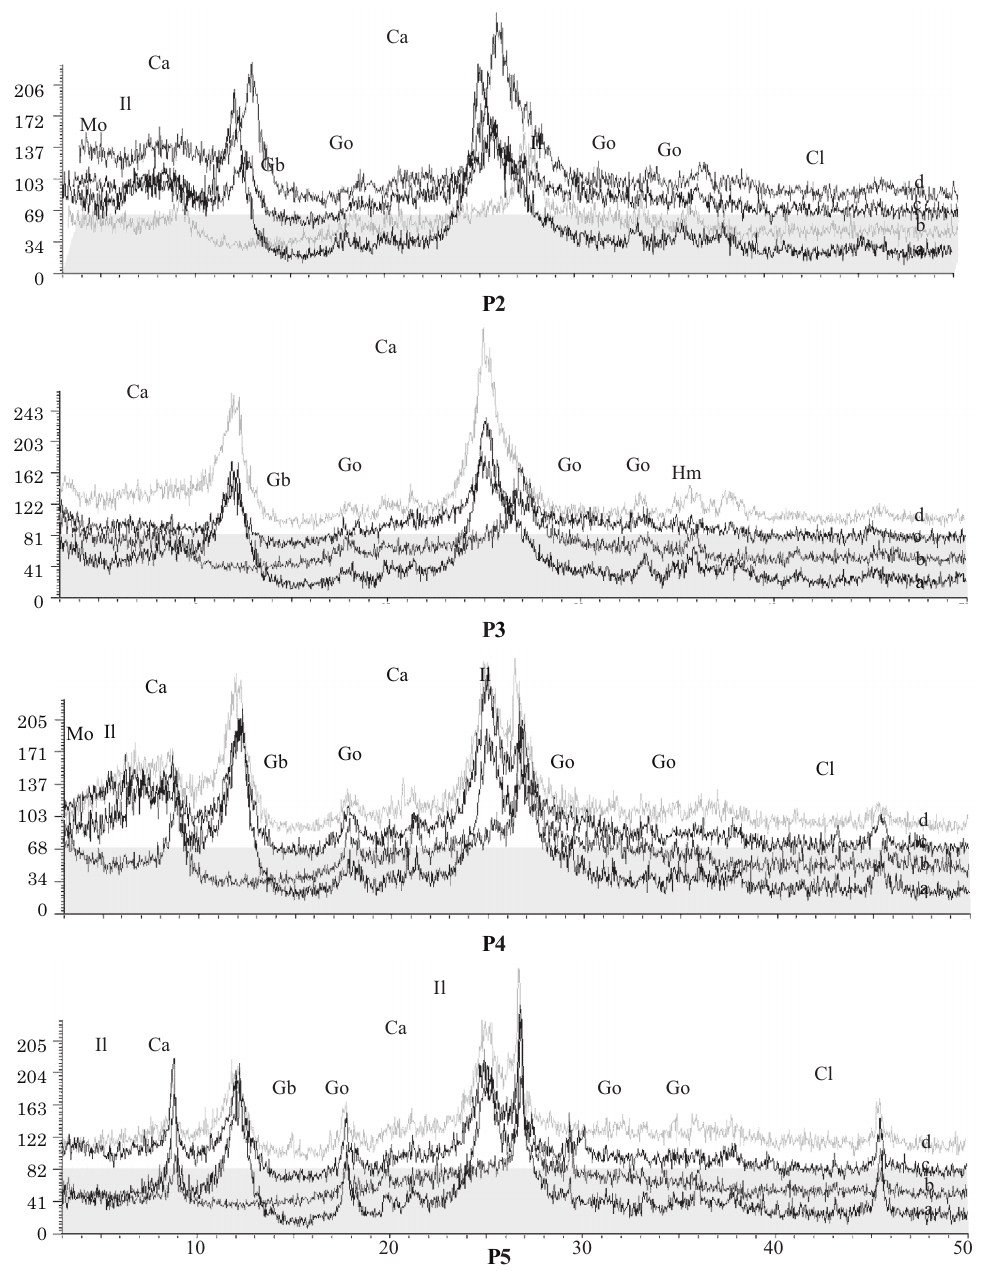
Figura 2. Difratograma de raios-X da fração argila dos perfis P2 (Bi2), P3 (Bt2), P4 (Cg) e P5 (C k g). Amostra seca ao ar (a); aquecimento a 550 o C (b); tratamento com dimetilsulfóxido (c); e tratamento com etilenoglicol (d). Mo=Montmorilonita; Mi=Mica; Il=Illita; Ca=Caulinita; Gb=Gibbsita; Go=Goethita; Hm=Hematita; e